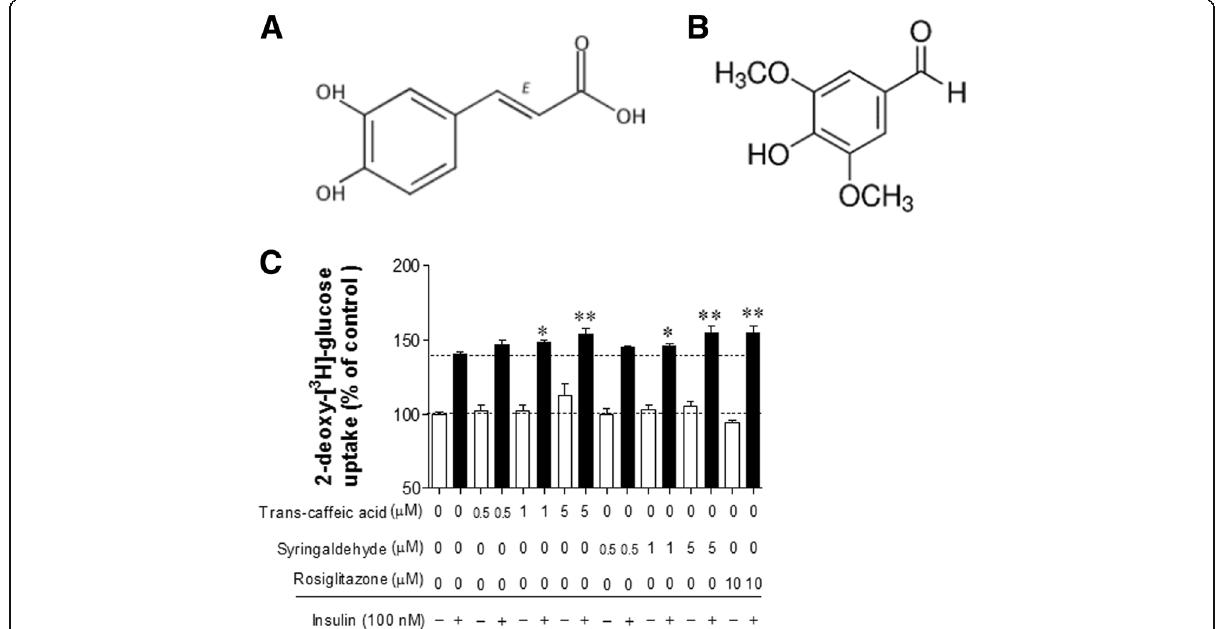
Fig. 1 Structures of two marker compounds in mulberry leaf extract and the effect of these two compounds on glucose uptake in differentiated C2C12 myotubes ( c ). Structures of trans-caffeic acid ( a ) and syringaldehyde ( b ). Differentiated C2C12 cells were incubated in serum-starved DMEM for 1 h and then treated with trans-caffeic acid or syringaldehyde 1 h. Thereafter, the medium was changed to Krebs-Ringer phosphate-HEPES buffer containing the prescribed concentrations of trans-caffeic acid or syringaldehyde for 30 min, and then cells were treated with 100 nM insulin for 30 min. After treatment with 2-deoxy-[ 3 H] – glucose (0.5 μ Ci/mL) and 2-deoxy-D-glucose (100 μ M) for 10 min, the reaction was terminated and glucose uptake activity was measured in lysed cells with a liquid scintillation counter (see Materials and methods). Rosiglitazone (10 μ M) was used as a positive control for glucose uptake in differentiated C2C12 myotubes. Data are expressed as the mean ± SEM of three independent experiments. * P < 0.05 and ** P < 0.01 versus insulin-stimulated glucose uptake in the untreated control